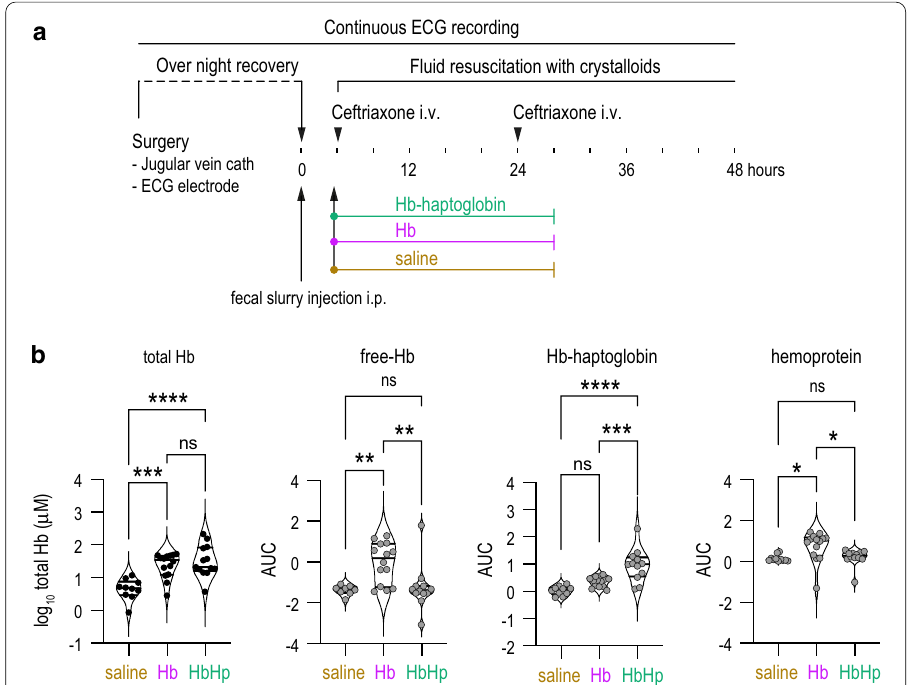
Fig. 1 Experimental setup and hemoglobin infusion protocol validation. a Setup scheme of the studies: a catheter was placed into the jugular vein and a telemetry ECG electrode was placed subcutaneously the day before the experiment. On the next day, the animals were randomized to a treatment group. Fecal slurry was injected i.p at T 0h to induce sepsis. 4 h later, the animals were treated with ceftriaxone and a continuous saline infusion was started to provide fluid resuscitation. At the same time ( T 4h ), we administered a bolus followed by continuous-rate infusion of saline, Hb or Hb–haptoglobin complexes for 24 h (Hb bolus 16 mg, Hb = continuous rate infusion 15 mg/h, haptoglobin was dosed at an iso-stoichiometric concentration with Hb). = b Besides the mortality study, we performed a separate study to determine plasma concentration of total Hb by spectrophotometry (left panel black symbols, indicated in heme equivalents), and plasma concentrations of CFHb, Hb–haptoglobin complex and hemoprotein by size-exclusion chromatography (gray symbols). Plasma was collected 3 h after starting the Hb or Hb–haptoglobin infusion ( T 7h ). p values: * < 0.05, ** < 0.01, *** < 0.001, **** <